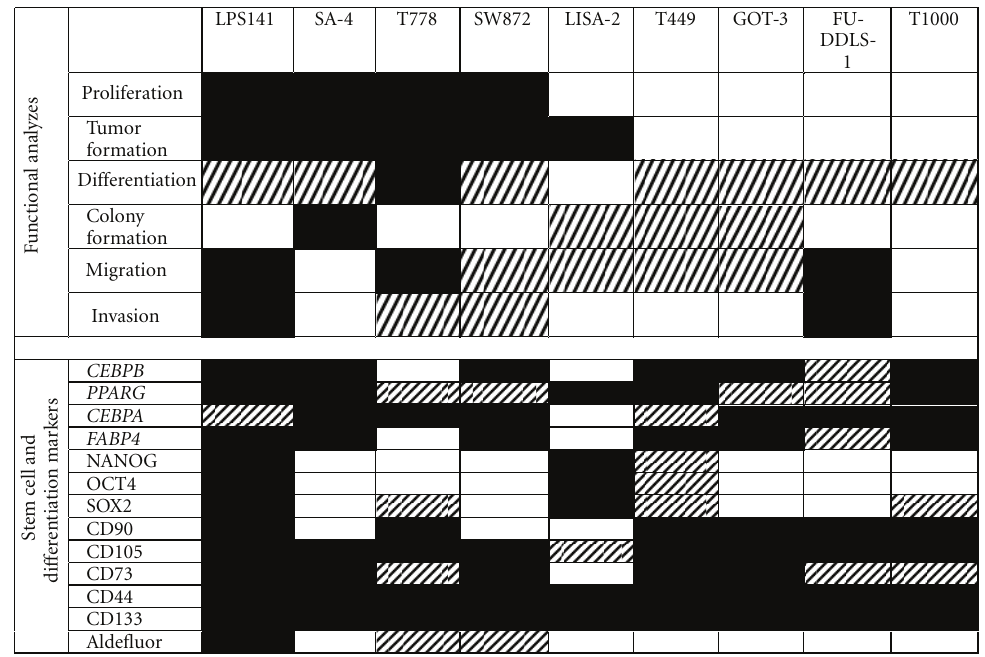
Figure 6: Heat map summarizing the LPS functional analyses and marker expression. Black indicates aggressive signature, grey indicates moderately aggressive signature, and white indicates a nonaggressive signature. Cell lines considered highly aggressive displayed a high proliferation rate; ability to form tumor; resistance towards di ff erentiation; high capacity for colony formation, migration and invasion; low expression of di ff erentiation markers ( CEBPB , CEBPA , PPARG , FABP4 ); high expression of pluripotency markers NANOG, OCT4, SOX2; high expression of stem cell surface markers CD90, CD105, CD73, and CD44; expression of cancer stem cell marker CD133 and Aldefluor in more than 3% of the cells. Cell lines considered moderately aggressive displayed the ability to undergo spontaneous di ff erentiation; moderate capacity to form colonies and to migrate or invade; moderate expression of di ff erentiation markers ( CEBPB , CEBPA , PPARG , FABP4 ) pluripotency markers NANOG, OCT4, SOX2 , and stem cell surface markers CD90, CD105, CD73, and CD44; CD133 and Aldefluor expression in (0.1–3%) of the cells. Cell lines considered non-aggressive displayed a low proliferation rate, did not form tumors in vivo ; adipocytic di ff erentiated at basal level; low capacity for colony formation, migration and invasion; high expression of di ff erentiation markers CEBPB , CEBPA , PPARG , FABP4 ; low expression of pluripotency markers NANOG, OCT4, SOX2; expression of stem cell surface markers CD90, CD105, CD73, and CD44 in a low percentage of the cells and undetectable expression of the cancer stem cell